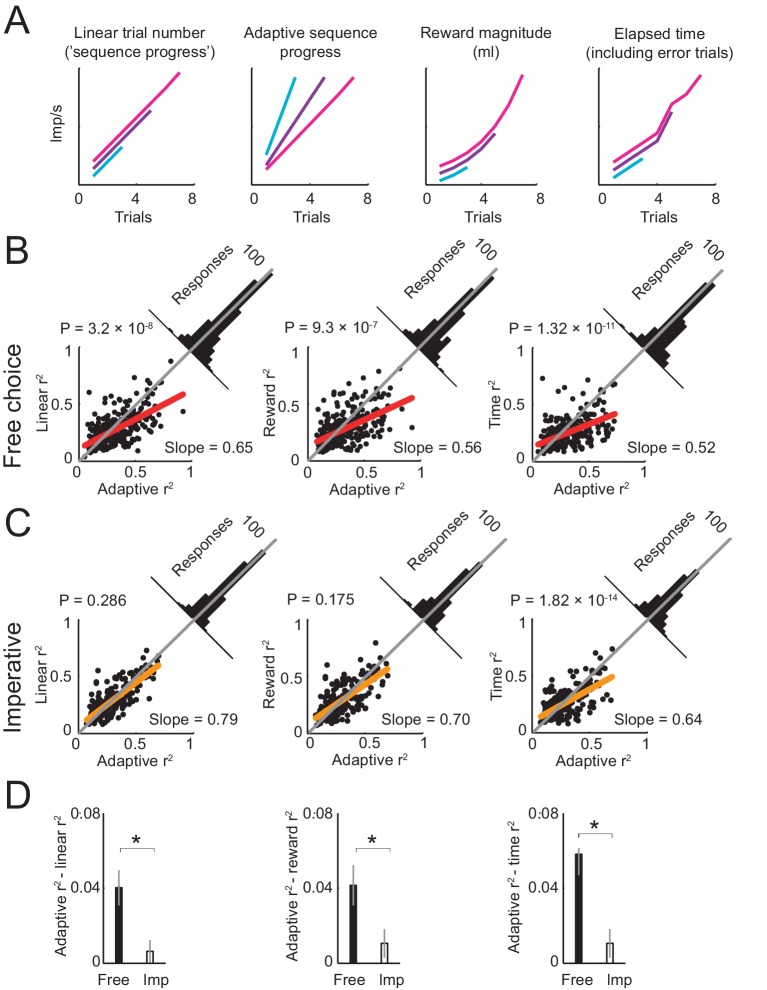
Comparing different models of sequence progress.(A) Schematic illustration of four models of gradual activity. Left to right: (i) linear non-adaptive sequence progress (cumulative record of correct trials within sequence; Equation 2); (ii) adaptive sequence progress (cumulative trial record normalized by the final sequence length; Equation 3); (iii) reward magnitude (saved juice amount in current sequence in ml, shown for a typical interest rate; Equation 4); (iv) elapsed sequence time (cumulative trial record including error trials; Equation 5). The curves are vertically separated for visibility. Values generated by the four models were used as regressors for neuronal activity. (B) Model comparison in free choice task. The adaptive progress model provided a significantly better fit compared to all alternatives. Each scatter plot compares the R2 (explained variance) obtained by fitting the adaptive progress model to the R2 obtained by fitting the non-adaptive progress (left), reward magnitude (middle), and elapsed time (right) models. Red lines: linear fits of R2 values for model pairs; deviation from unity line (gray) towards the horizontal axis indicates better fit of adaptive model. Angled histograms show distributions of R2 differences; p-values indicate deviation from normal distribution (Kolmogorov-Smirnov test). Each plot is based on all neuronal responses with significant fits for both compared models. (C) Model comparison for the imperative task. The adaptation model did not provide better fits compared to non-adaptive and reward magnitude models. Each plot is based on all neuronal responses with significant fits for both compared models. (D) Comparison of differences in model fit (R2) between free choice and imperative tasks. All R2-differences in free choice task but none in the imperative task were significantly greater than zero (p<0.05, two-tailed t-test). All differences in free choice task were significantly greater than those in imperative task (p<0.05, paired t-test). Each plot is based on all neuronal responses with significant fits for both free choice and imperative task.